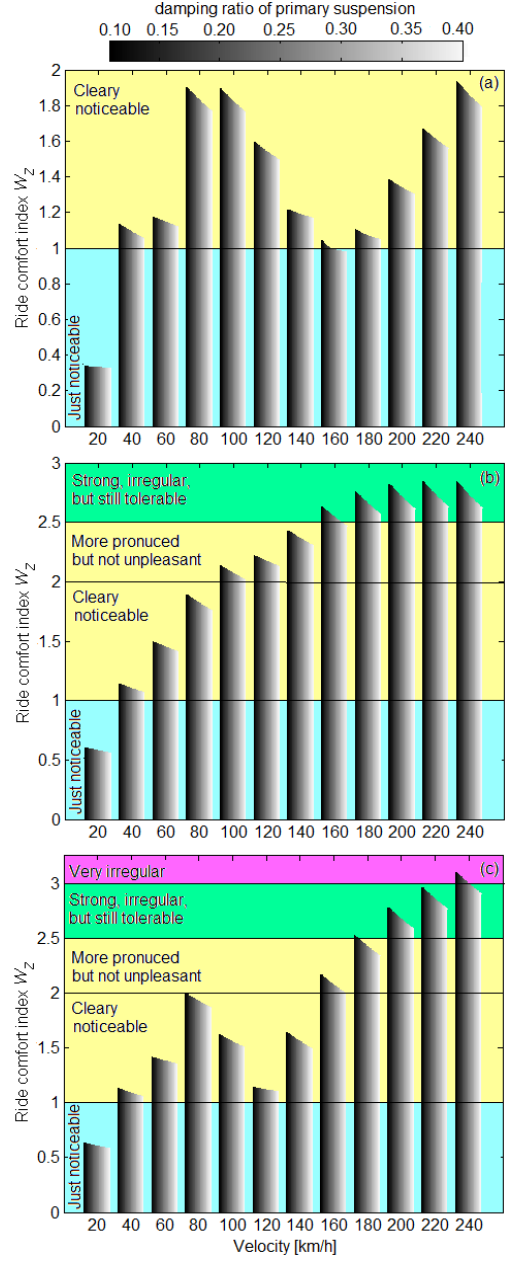
Figure 18. Ride comfort index W z depending on the damping ratio of primary suspension: ( a ) in point C ; ( b ) in point B 1 ; ( c ) in point B 2 .